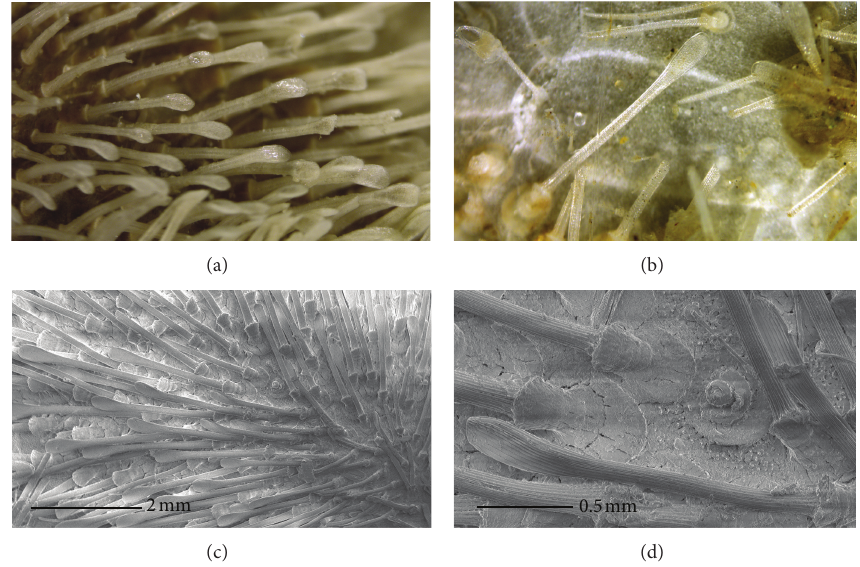
Figure 3: Plastron spines of Brisaster fragilis . ((a) and (b)) Stereomicroscope images; ((c) and (d)) SEM micrographs; ((a) and (c)) mid-section view showing the fan-like arrangement of spines; ((b) and (d)) close-up view of spatulate spines and tubercles.